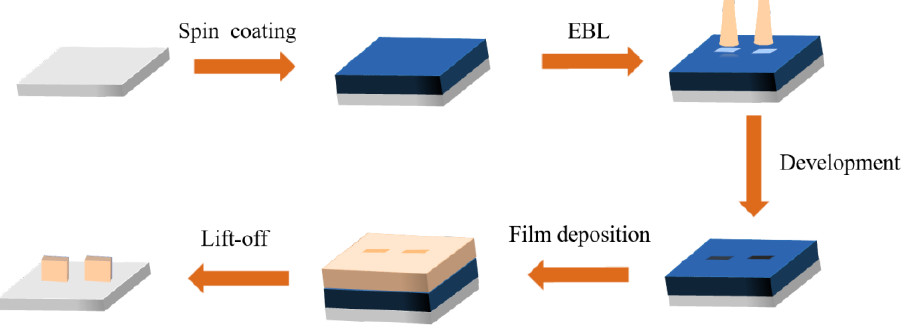
Figure 1 . Schematic diagram of the fabrication process. Figure 1. Schematic diagram of the fabrication